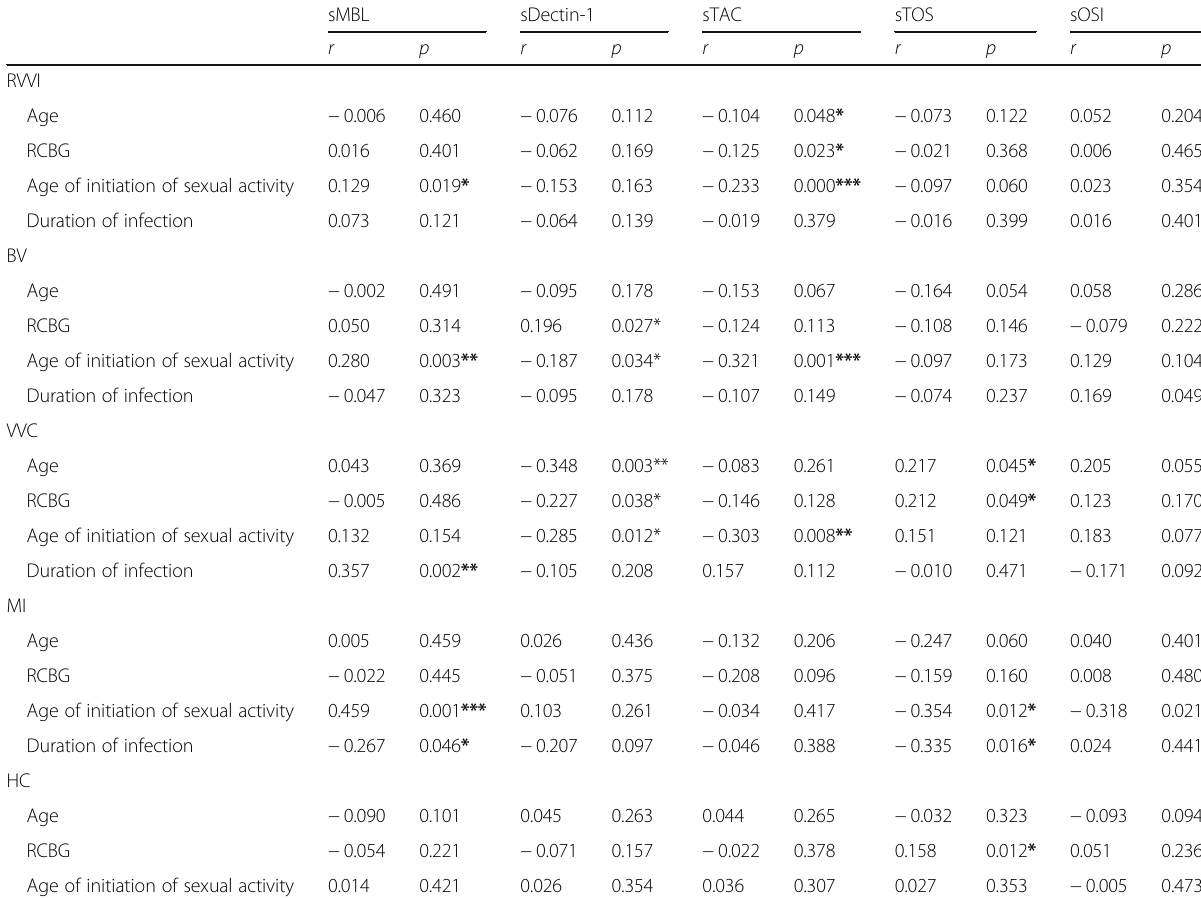
Table 3 Correlation analysis of serum biomarkers with confounding parameters in RVVI, RVVI types, and